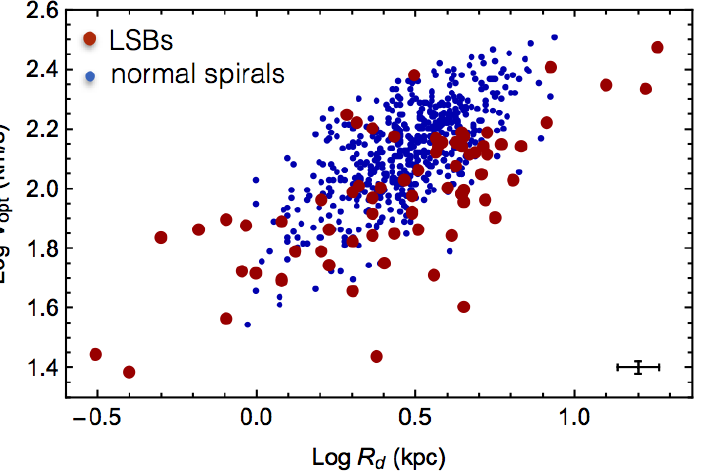
Figure 13. Optical velocity V opt vs. disc scale lengths in LSB galaxies (red) and in normal spirals (blue) [157]. The typical fractional observational uncertainties are 5% in V opt and 15% in R d , (see the right-down corner). Image reproduced from